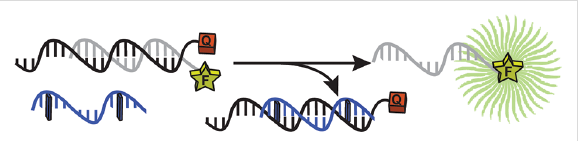
Figure 4: Outline of the displacement assay principle, in which a photoswitchable PNA probe (blue) hybridizes to a complementary quencher-labelled single-stranded (ss) DNA (black) and replaces a fluorescent-labelled ssDNA (grey); F = fluorescein; Q = black hole quencher; blue rectangle = tetra- ortho -fluoroazobenzene moiety.